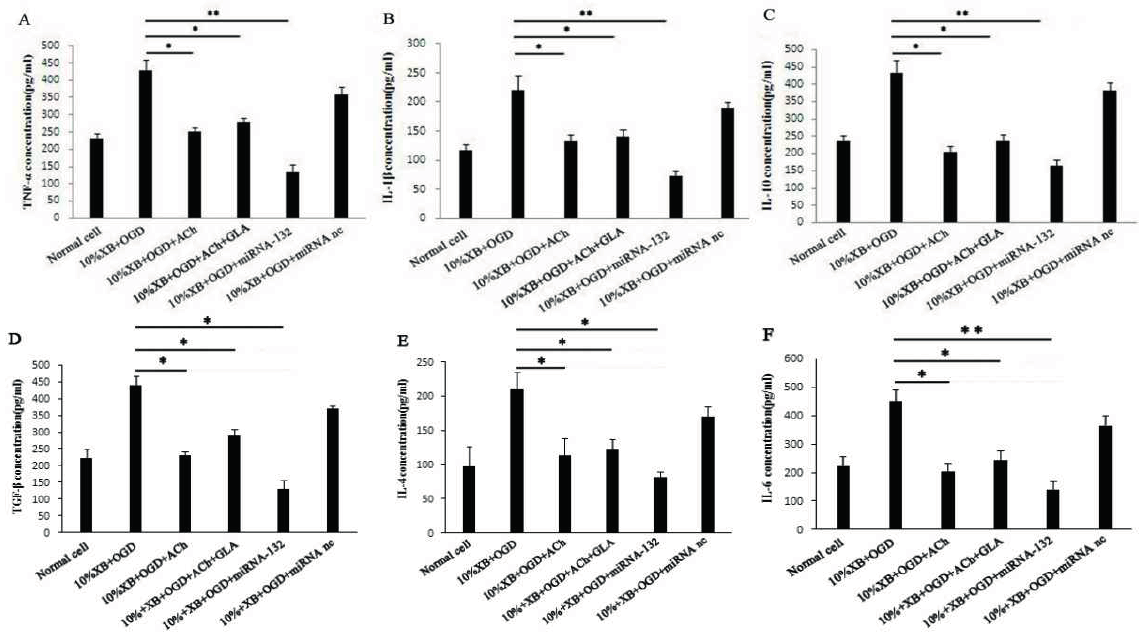
Figure 4: Testing of inflammatory factors in the double cell culture system 24 h after miRNA-132 was transfected and stably expressed: (A)